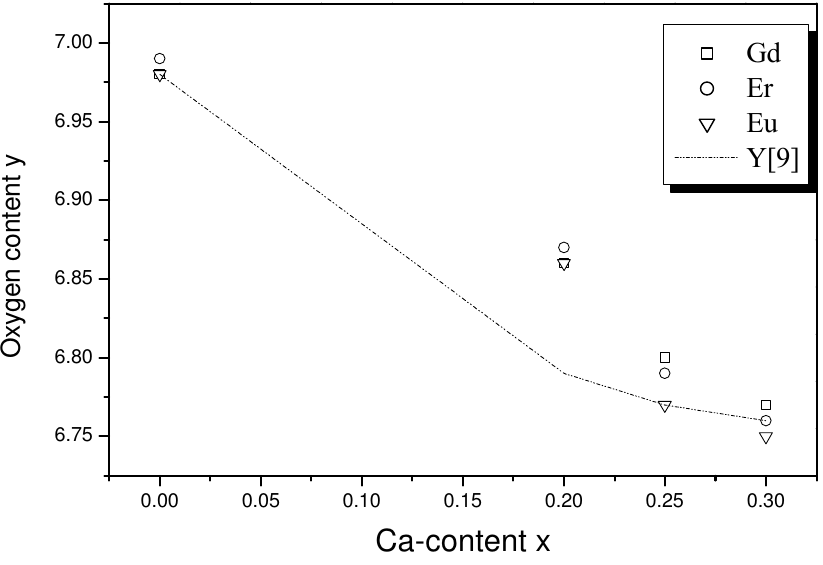
Fig. 5 The oxygen content (y) dependence from Ca-content (x) in RCaBCO (R= Eu, Gd, Er or